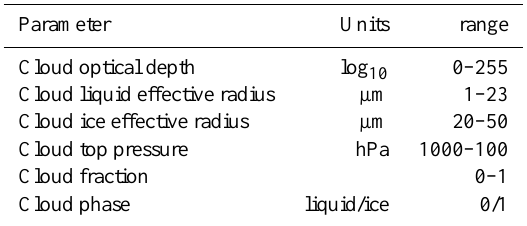
Table 3. ATSR retrieved cloud properties units and range for GRAPE.